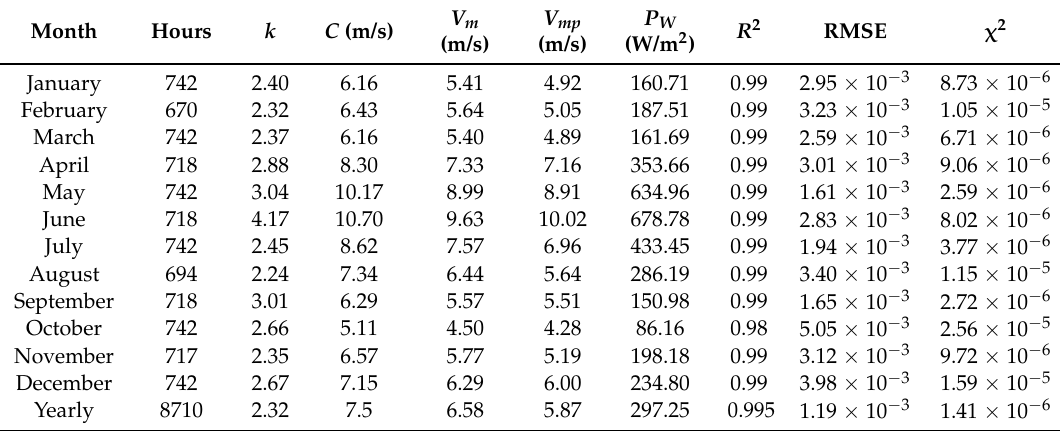
Table 3. Monthly and Yearly Wind Characteristics for Baburband at 80 m height using modified maximum likelihood method (MMLM) for